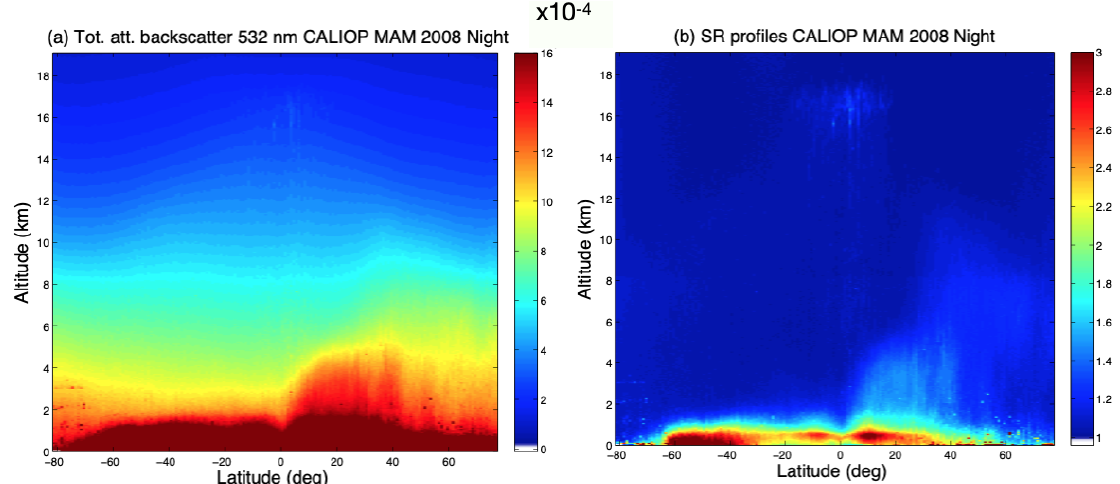
Figure 7. (a) Attenuated total backscatter profiles (km − 1 sr − 1 ) and backscatter ratio profiles (b) observed by CALIOP at 532nm at night and averaged over longitudes and time during MAM